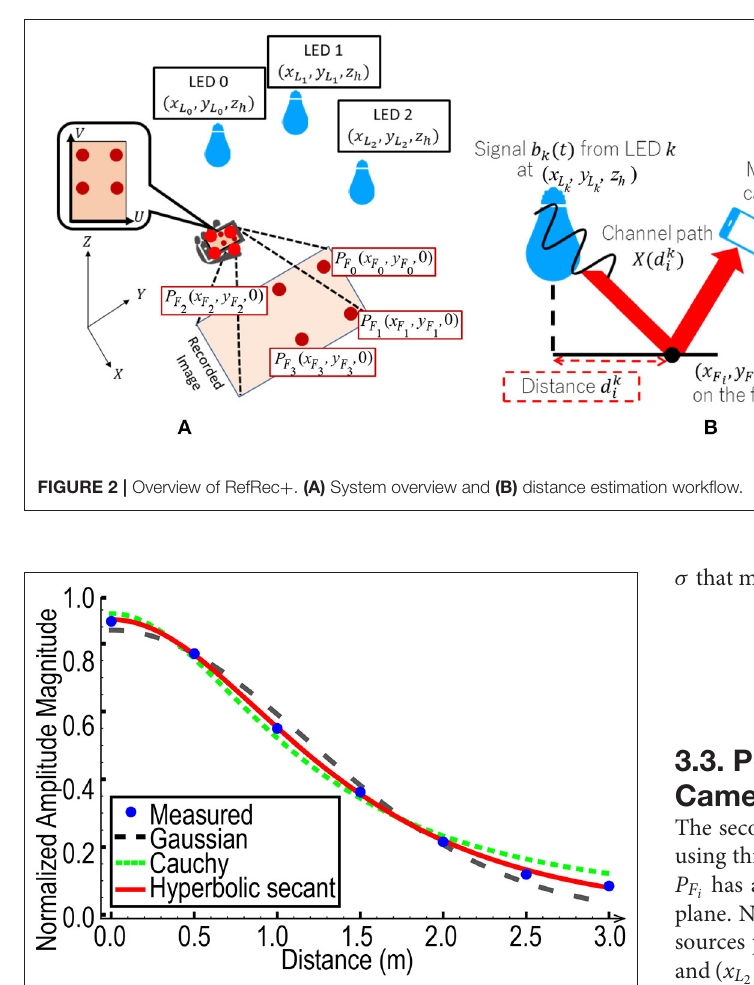
FIGURE 3 | Comparison between different diffusion